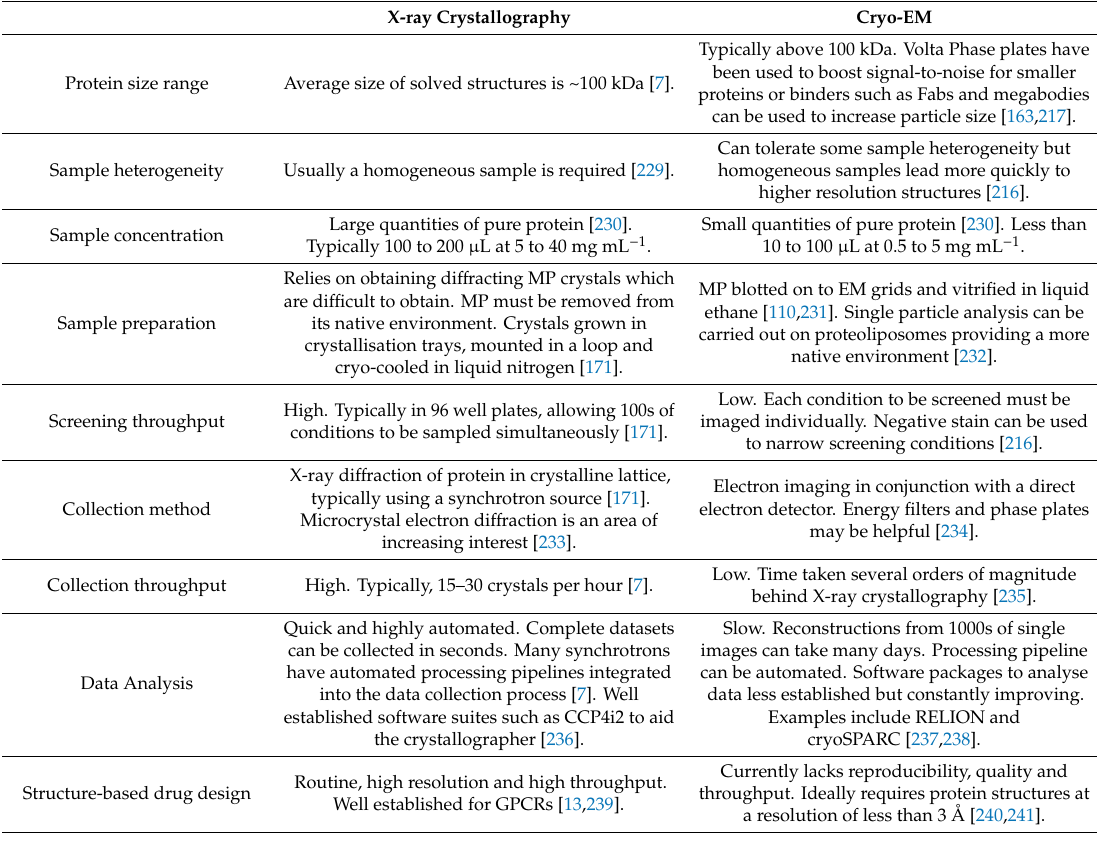
Table 3. A comparison of the di ff erent variables that a ff ect structural studies undertaken by X-ray crystallography and single particle Cryo-EM. X-ray